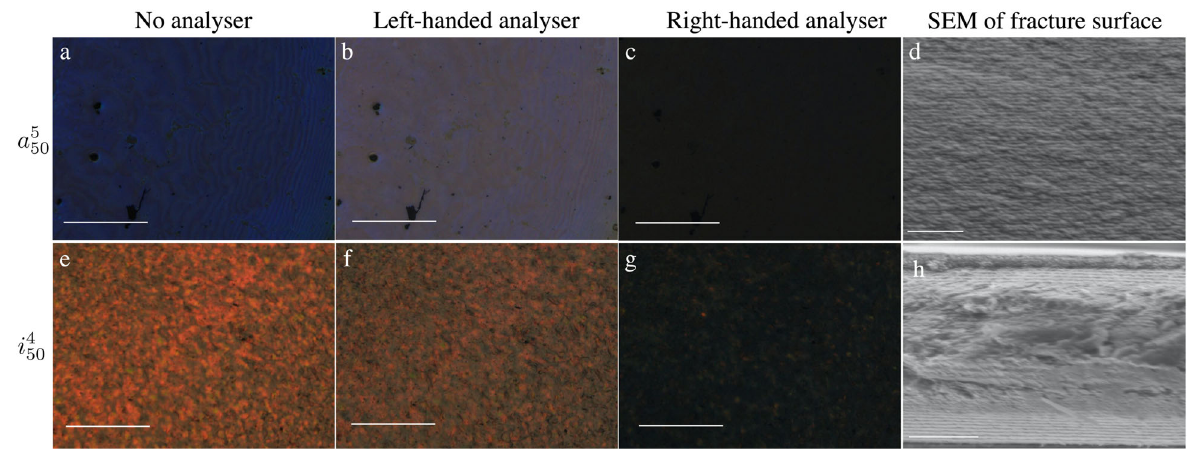
Fig. 6 Optical and electron microscopy characterization of fi lms obtained by drying suspensions of long and short CNCs, respectively. Films dried from W = 3 wt.% suspensions of long (top) and short (bottom) CNCs as imaged by POM ( a – c , e – g , scale bar 500 µ m) and SEM ( d , scale bar 2 µ m; h , scale bar 5 µ m). The long-CNC suspension produces uniform vertical helix orientation m and a fi nal pitch as predicted from equilibrium data. The fi lm from short CNCs has non-uniform texture and cross section, with fi nal pitch much longer than